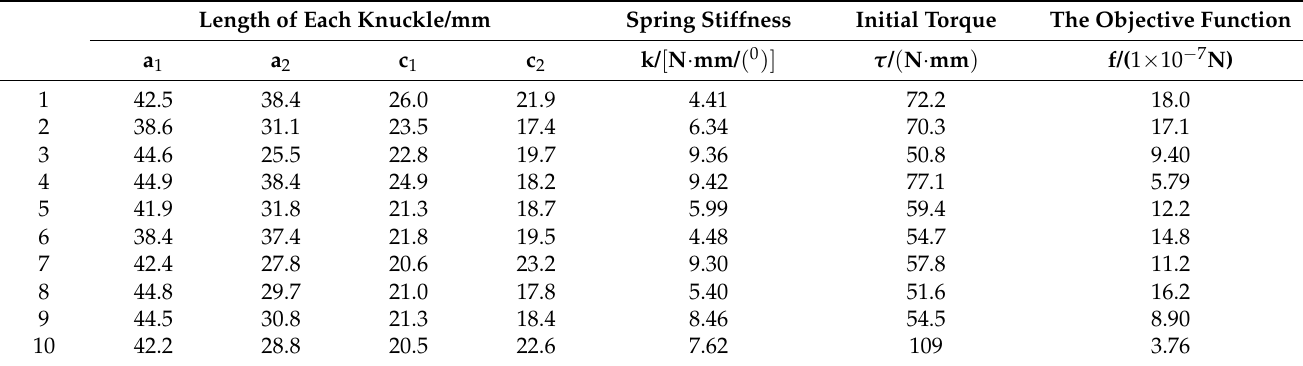
Table 1. Structural parameters of each knuckle of the